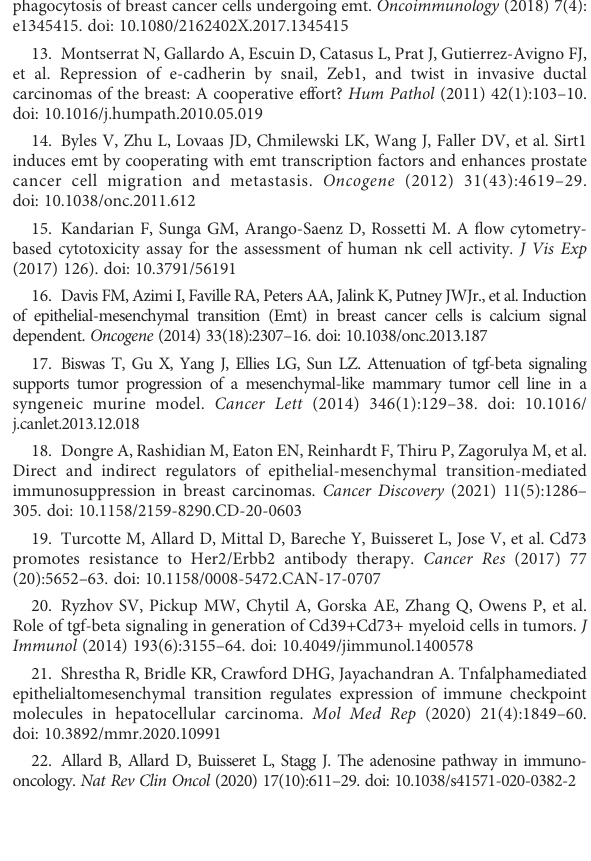
positive (CD73+) cells and left panel: representative FACS histograms of indicated cells stained with control isotype or anti-CD73 antibody. Bars represent means from three independent experiments ± SD; *P < 0.05 calculated by unpaired t test. FIGURE S3 Ki67 quanti fi cation in NK cells isolated from healthy donors (NKD-3 and -4) and NK92-MI cells following CADO treatment. Percentage of Ki67- positive cells in NKD-3, NKD-4, and NK92-MI after treatment for 6 days withCADOat5and10µM.ForNK92-MI,barsrepresentthemeanofthree independent experiments ± SEM (*P < 0.05, ** P < 0.01 calculated by unpaired t-test)Table S1 Sequence of SYBR-GREEN RT-qPCR primers used for ampli fi cation of immunoprecipitated DNA samples from ChIP assays. Information about the TNBC patient described in Figure 3. The table shows the METABRIC 258 TNBC patient and sample IDs; sex; ER, HER2, PR, NT5E status, mRNA expression of NT5E , CDH1, SNAI1 and VIM. NP: Not pro fi